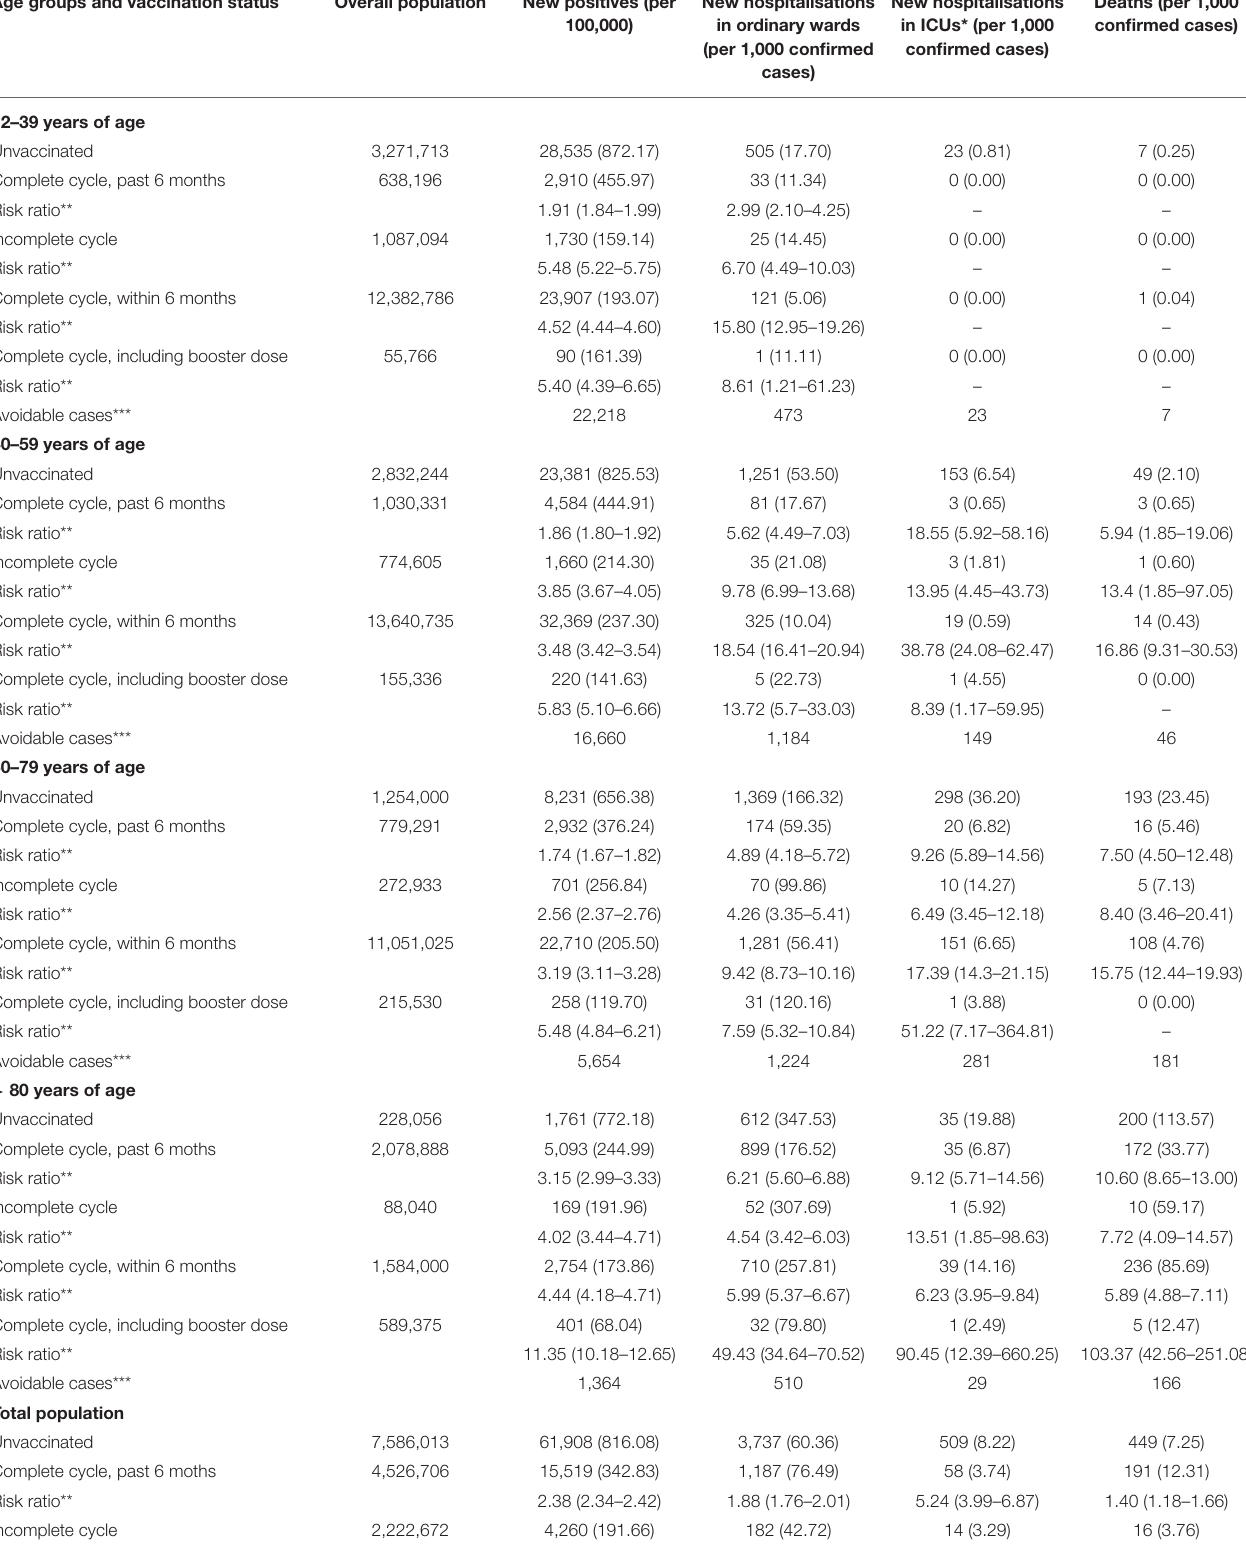
TABLE 1 | Hospitalisations and deaths due to coronavirus disease 2019 (COVID-19), by age groups and vaccination status, nearing 30 days to November 24,